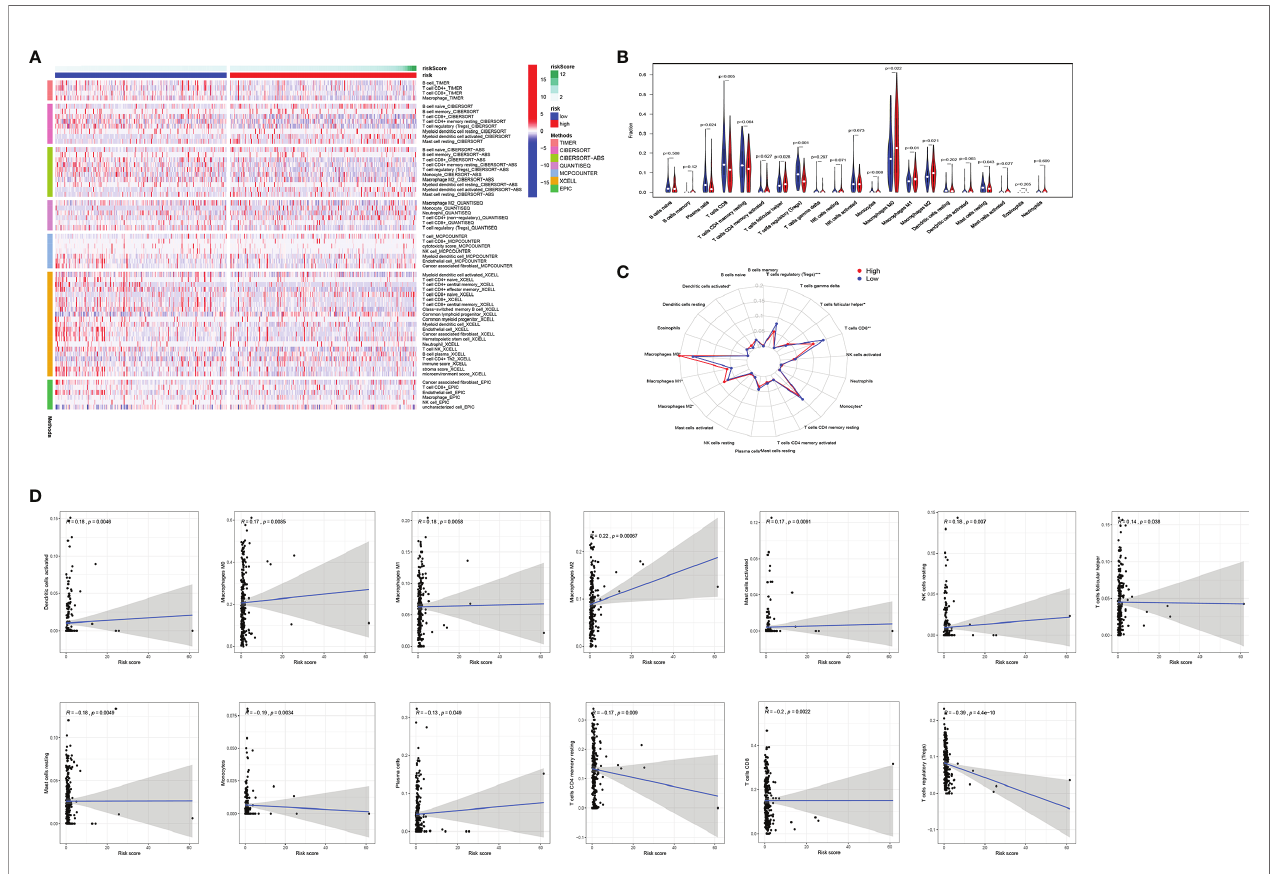
FIGURE 5 | Comparison of immune signature between the high-risk and low-risk groups of EC patients. (A) The in fi ltration of 21 types of immune cells in high-risk and low-risk groups was estimated by TIMER, CIBERSORT, CIBERSORT-ABS, QUANTISEQ, MCPCOUNTER, XCELL, and EPIC database. (B, C) Comparison of tumor-in fi ltrating immune cells between different risk groups. (D) The correlation of risk score and tumor-in fi ltrating immune cells. EC, endometrial